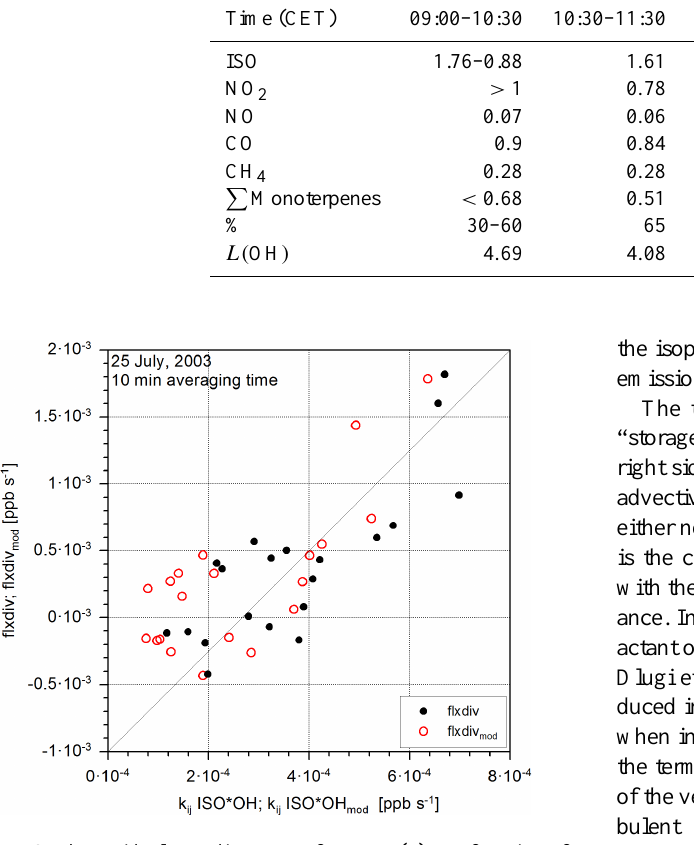
Figure 3. The residual flux divergence from Eq. (5) as a function of the mean reaction rate for OH and OH mod